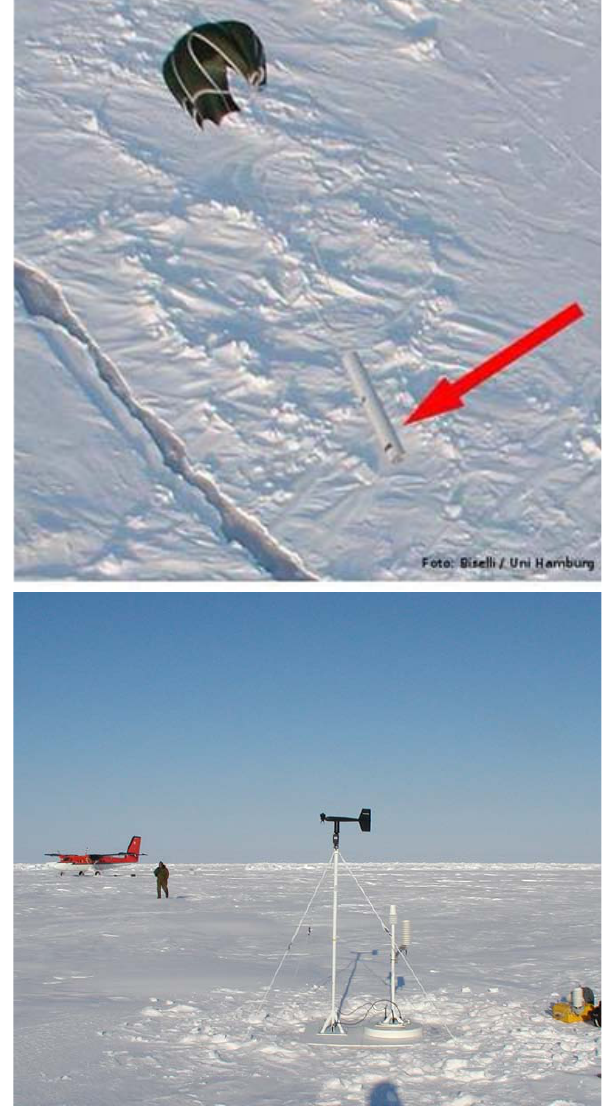
Fig. 1. Above: CALIB buoy dropped from Twin Otter aircraft at 300m altitude and descending on parachute. Below: PAWS buoy G after installation with Twin Otter aircraft landed on ice.